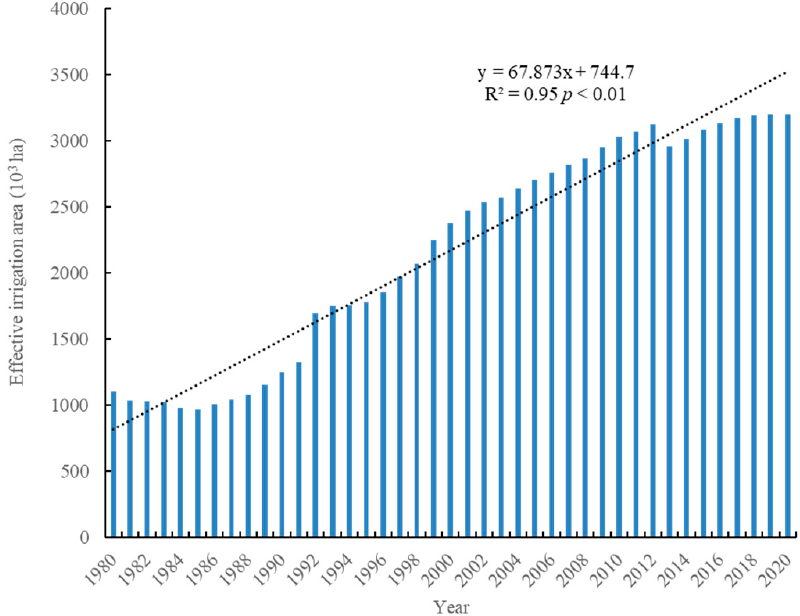
Figure 10. Effective irrigated area of Inner Mongolia Autonomous Region from 1980 to 2019.